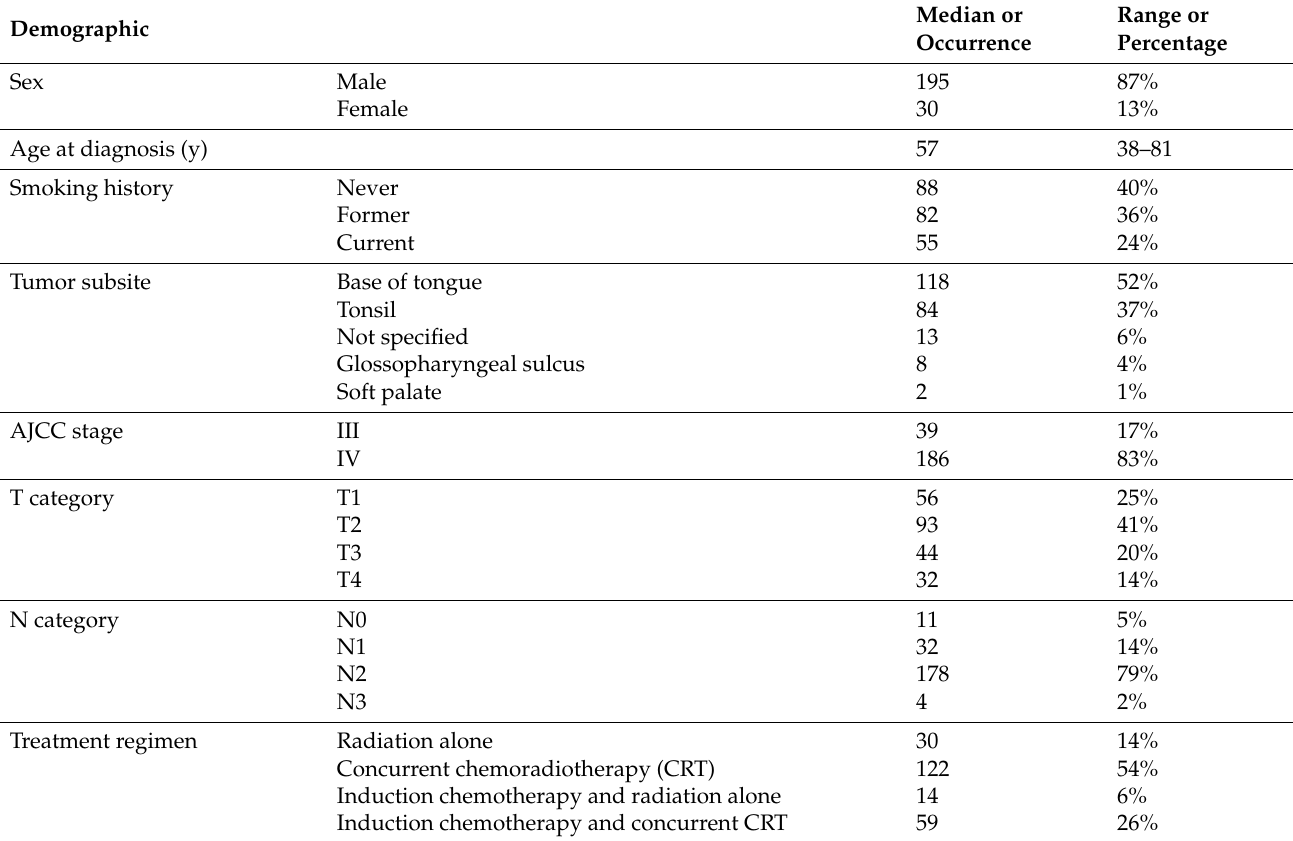
Table 1. Patient demographic and clinical characteristics (n =